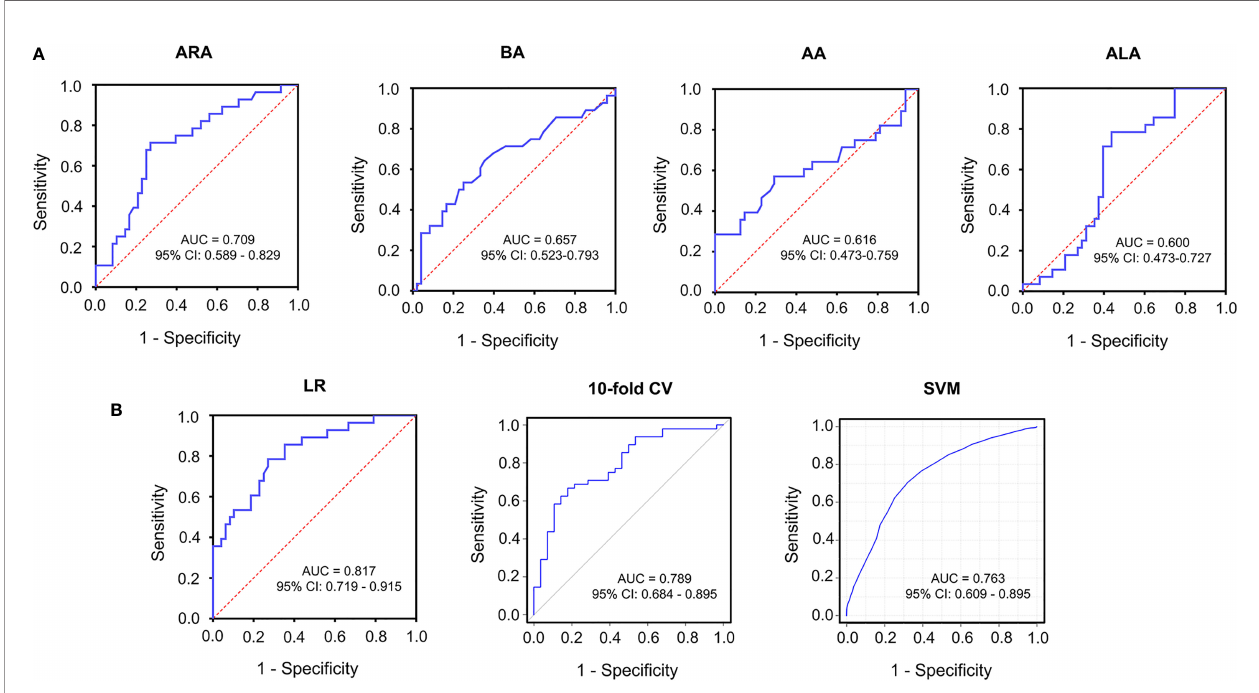
FIGURE 4 | Receiver operating characteristics curve for signi fi cantly altered serum metabolites in the comparison between vitiligo patients and healthy individuals. (A) ROC curves of ARA with AUC = 0.709, BA with AUC = 0.657, AA with AUC =0.616, ALA with AUC = 0.600. (B) ROC curves of combined models selected from four differential fatty acids using LR (AUC = 0.817), 10-fold CV (AUC = 0.789), SVM (AUC = 0.763), respectively. ROC, receiver operating characteristics; AUC, area under the curve; LR, logistic regression; 10-fold CV, 10-fold cross validation; SVM, supporting vector machine; CI, con fi dence